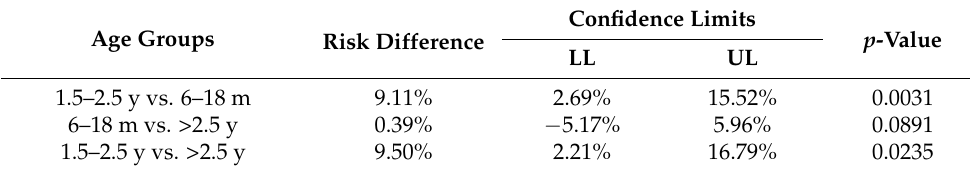
Table 9. Risk differences of brucellosis between different age groups of wild boars.